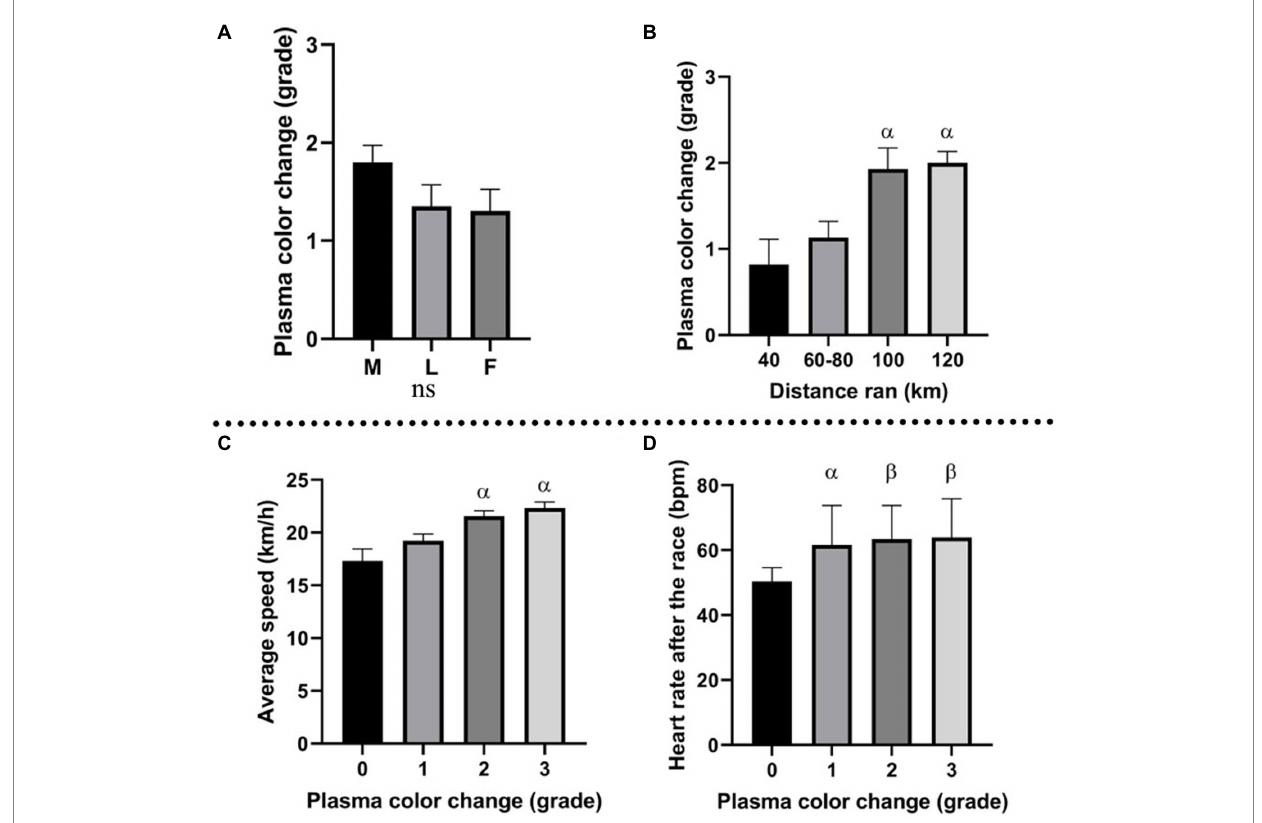
FIGURE 2 (A) Plasma color change (grade) in horses eliminated for metabolic reasons (M), lameness (L), and horses that finished the race (F); (B) association between distance ran by the horses and plasma color change grade; α : p ≤ 0.05 vs. 40 km; (C) association between plasma color change grade and average speed during the race; α : p ≤ 0.001 vs. grade 0; (D) association between plasma color change (grade) and HR after the race (bmp); α : p ≤ 0.05, vs. grade 0, β : p ≤ 0.01 vs. grade